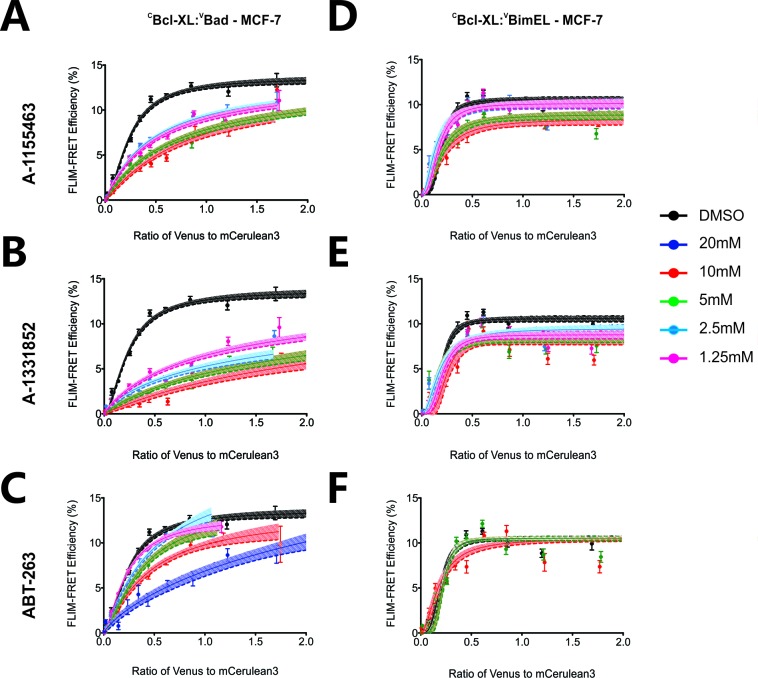
FLIM-FRET binding curves for VBad (left) and VBimEL (right) to CBcl-XL in MCF-7 cells in the presence of different concentrations of BH3-mimetics.The curves illustrate the extent of binding for DMSO treated controls (black), or cells treated with 1.25 μM (pink), 2.5 μM (light blue), 5 μM (green), 10 μM (red), and 20 μM (dark blue) BH3-mimetics: (a and d) A-1155463, (b and e) A-1331852, and (c and f) ABT-263. Data points in FLIM-FRET binding curves correspond to the average FLIM-FRET efficiency for binned data (20 < cells/bin < 3,000). Error bars, SEM; shadowed area, 95% confidence interval for the best fit of the model to the data.10.7554/eLife.37689.013Figure 2—figure supplement 4—source data 1.Source data fitted to a Hill equation to generate FLIM-FRET binding curves for Bad and BimEL to Bcl-XL in MCF-7 cells.